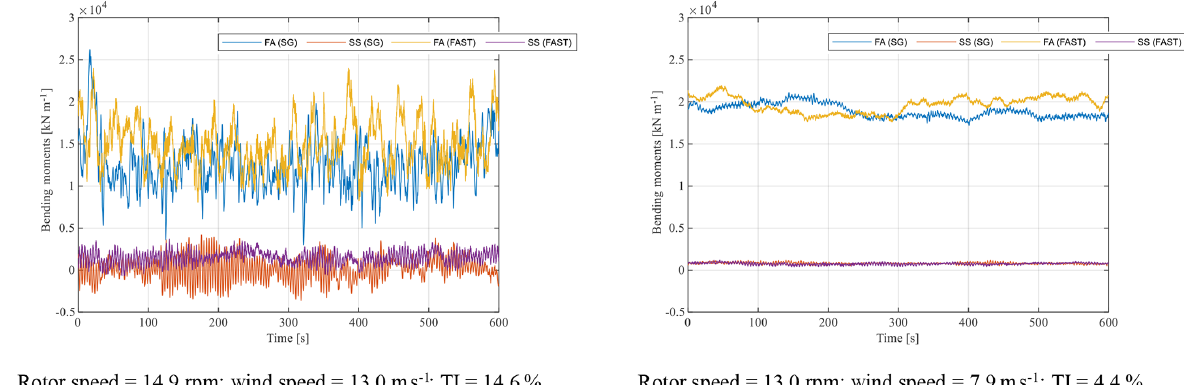
Figure 13. FA and SS bending moments in the bottom instrumented section, considering two different operating situations and comparing with numerical FAST results (TI: turbulence intensity).